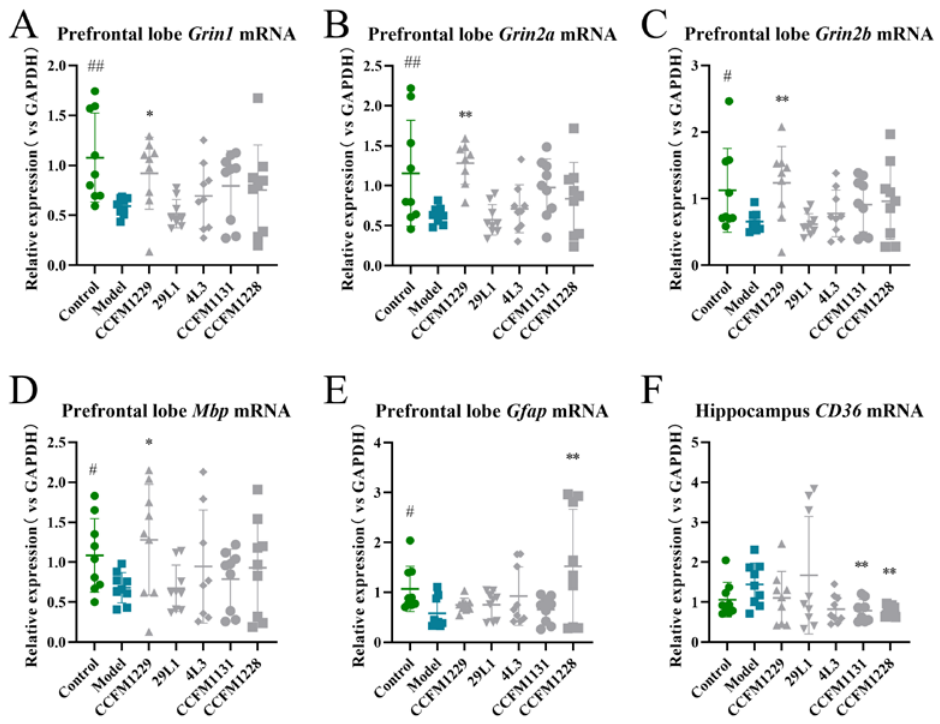
Figure 4. The expression of specific genes. # p < 0.05; ## p < 0.01; * p < 0.05; ** p < 0.01; comparing with depression group.